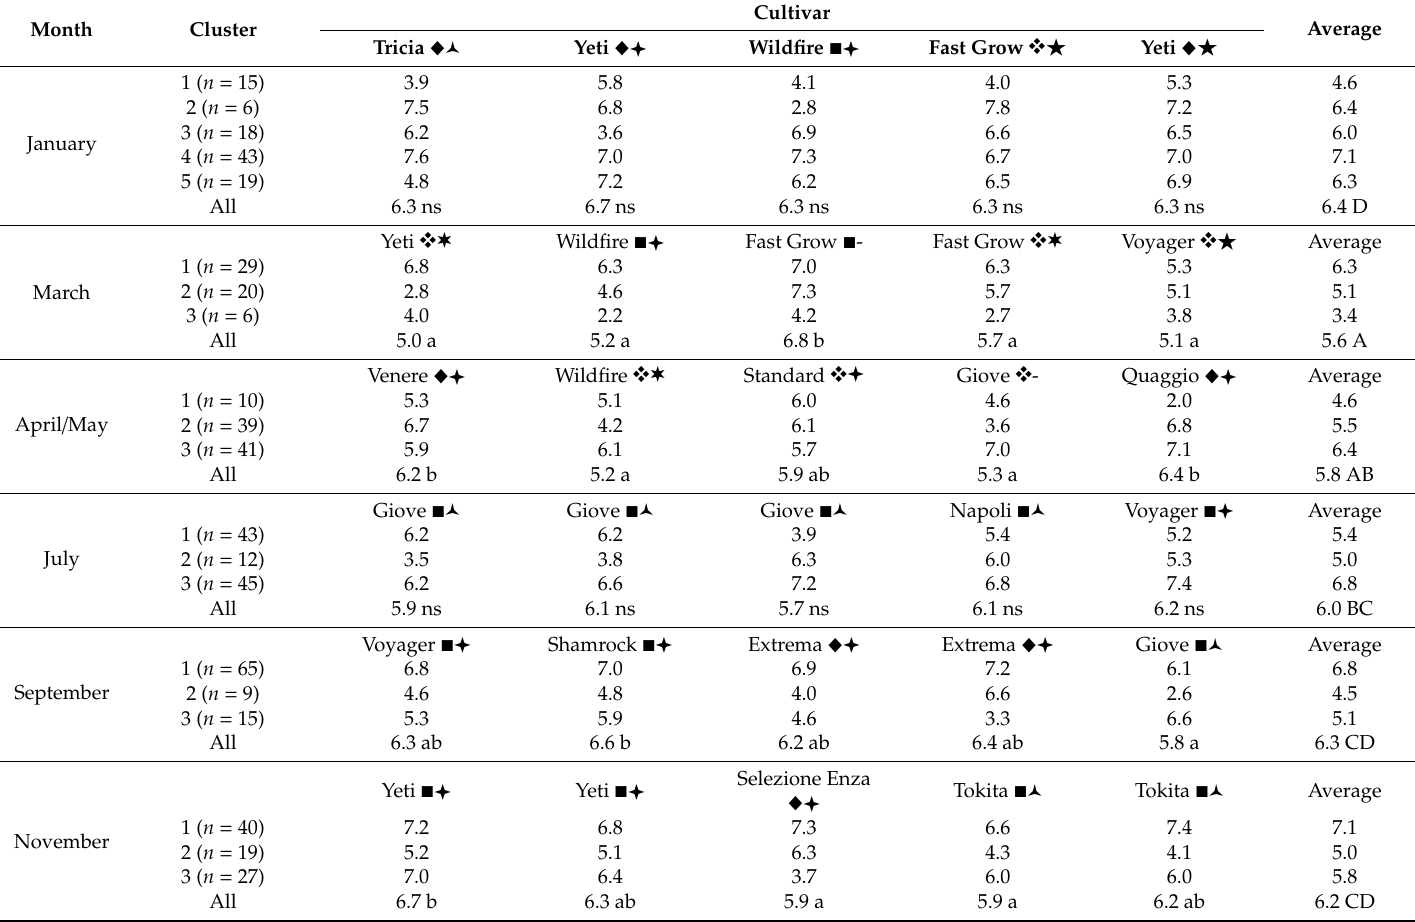
Table 1. Cultivation and origin details of rocket samples used for sensory and consumer analyses.